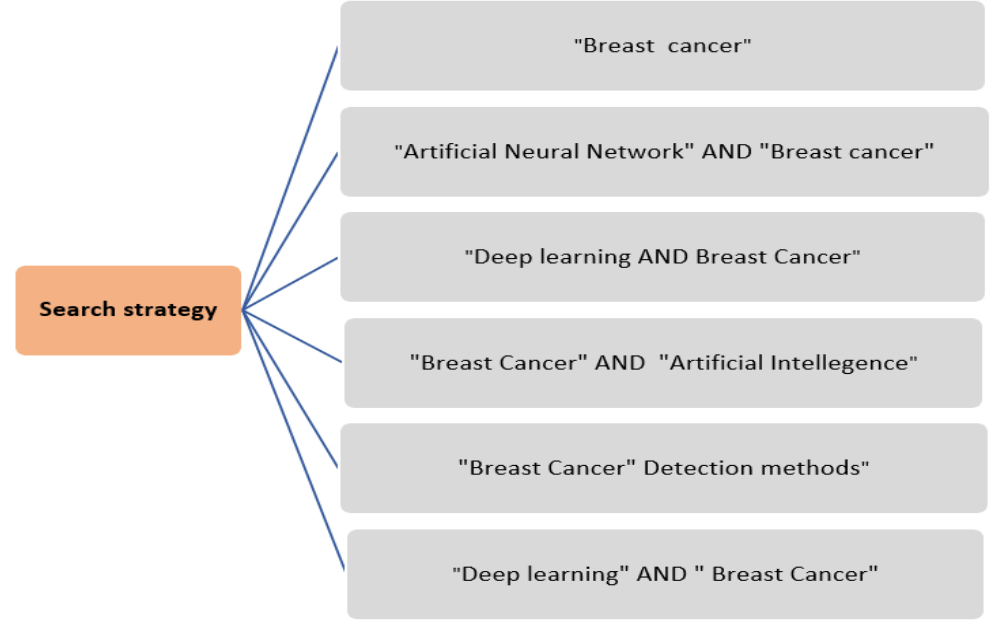
Figure 8. The search string used in the search strategy.